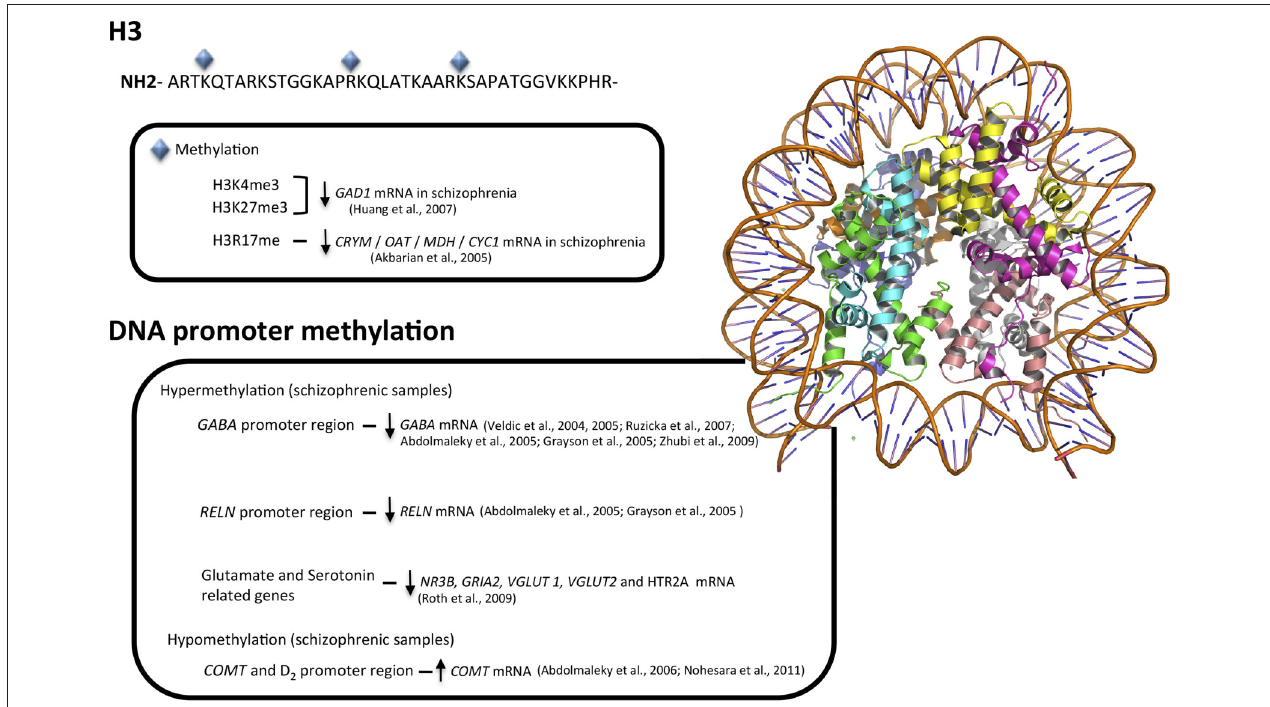
FIGURE 1 | Major epigenetic findings in schizophrenia. Above, histone modifications that result in euchromatin or heterochromatin states, allowing transcription factors access to genes or blocking transcription at specific loci. Below, hyper- and hypo-methylation patterns associated with schizophrenia in GABA, glutamate, serotonin, and dopamine neurotransmitter